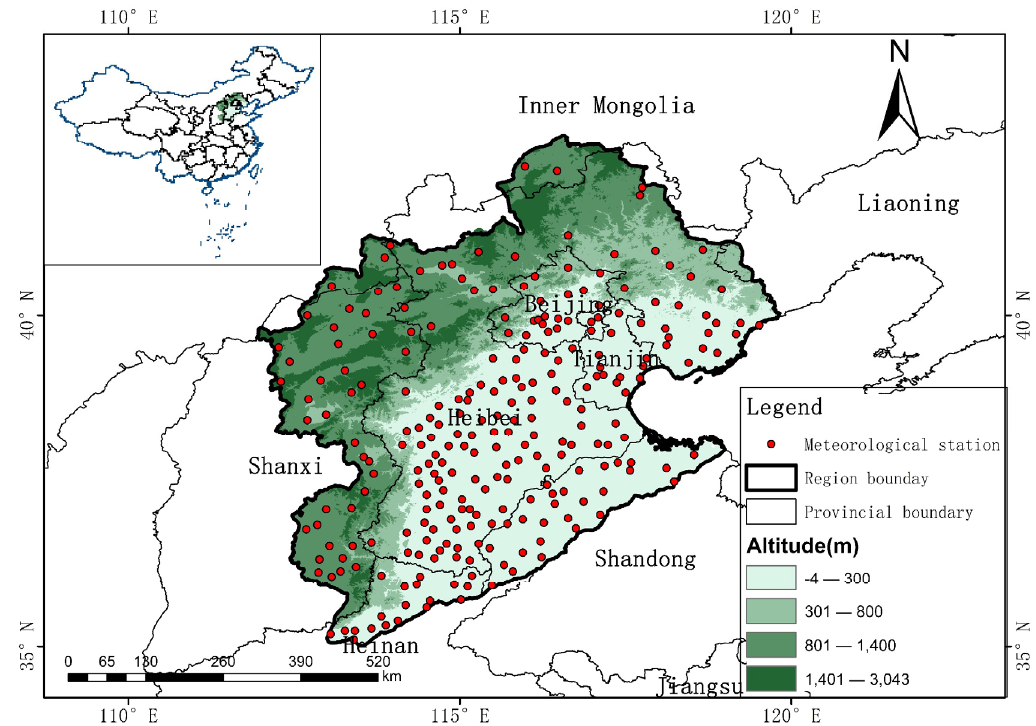
Figure 2. Schematic diagram showing selected stations.